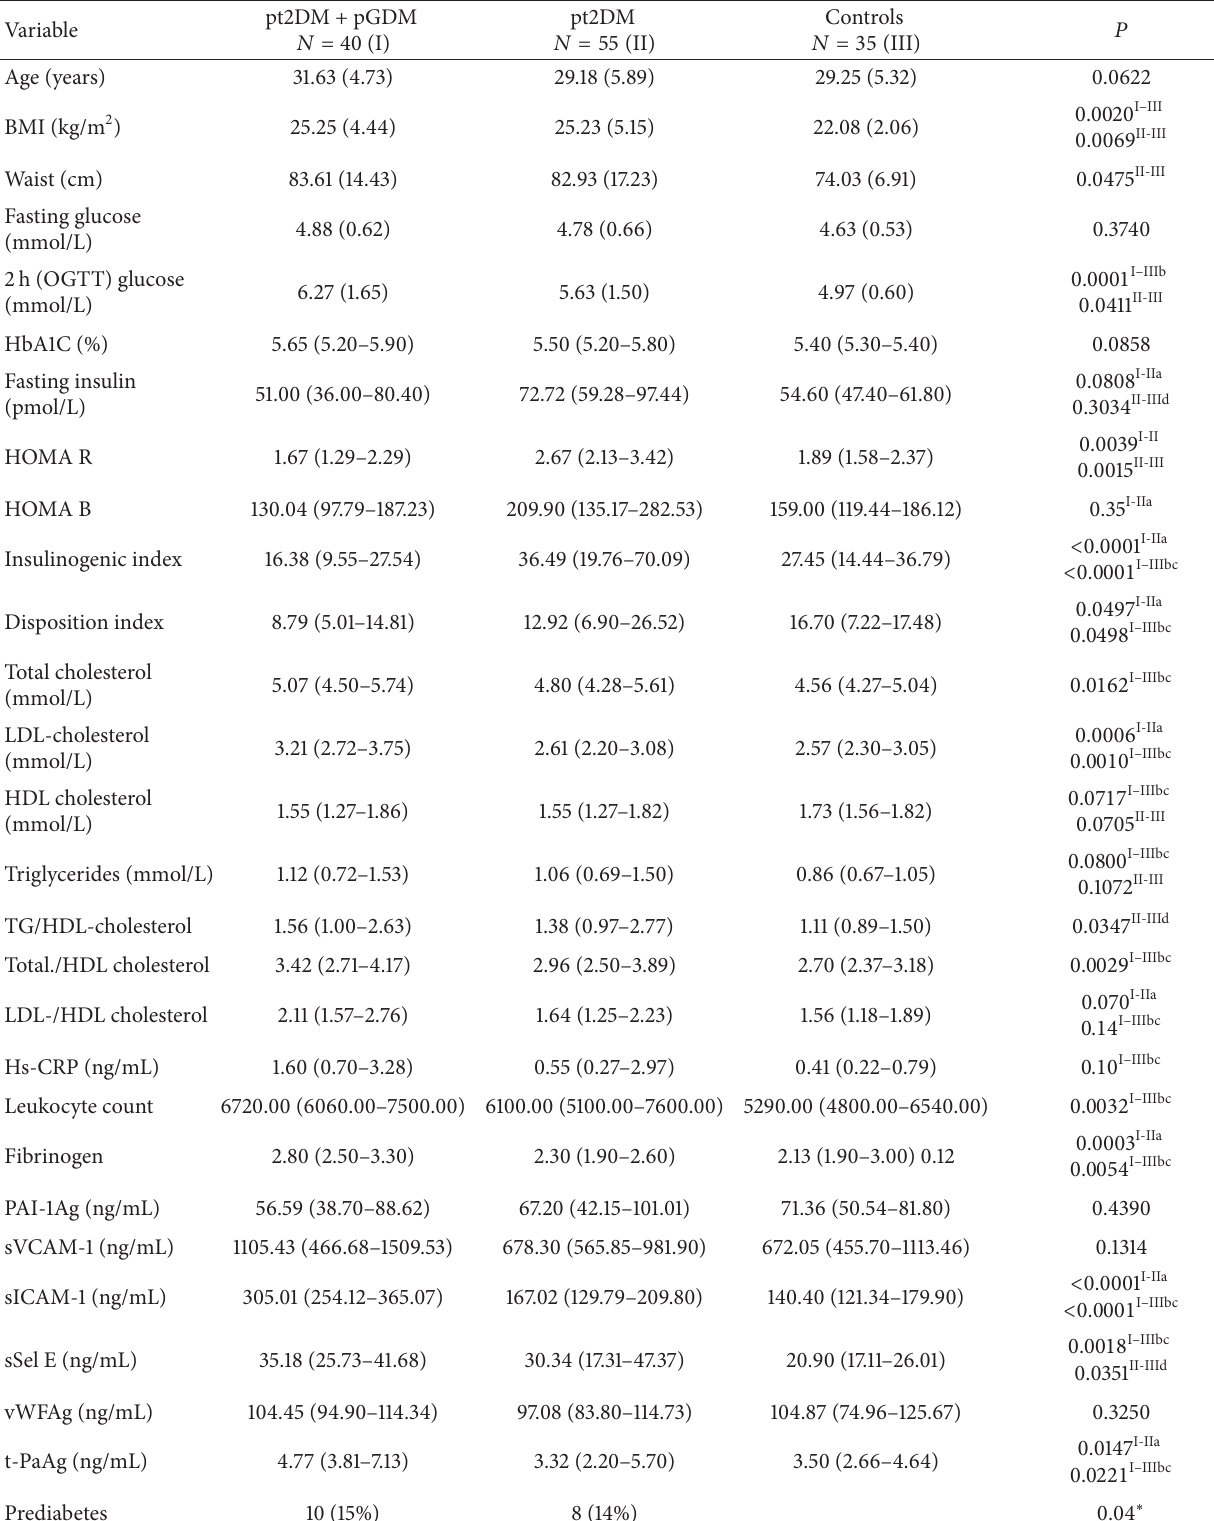
Table 1: Clinical characteristics of the study participants stratified into three groups: women with both pt2DM and pGDM, women with pt2DM but without pGDM, and control